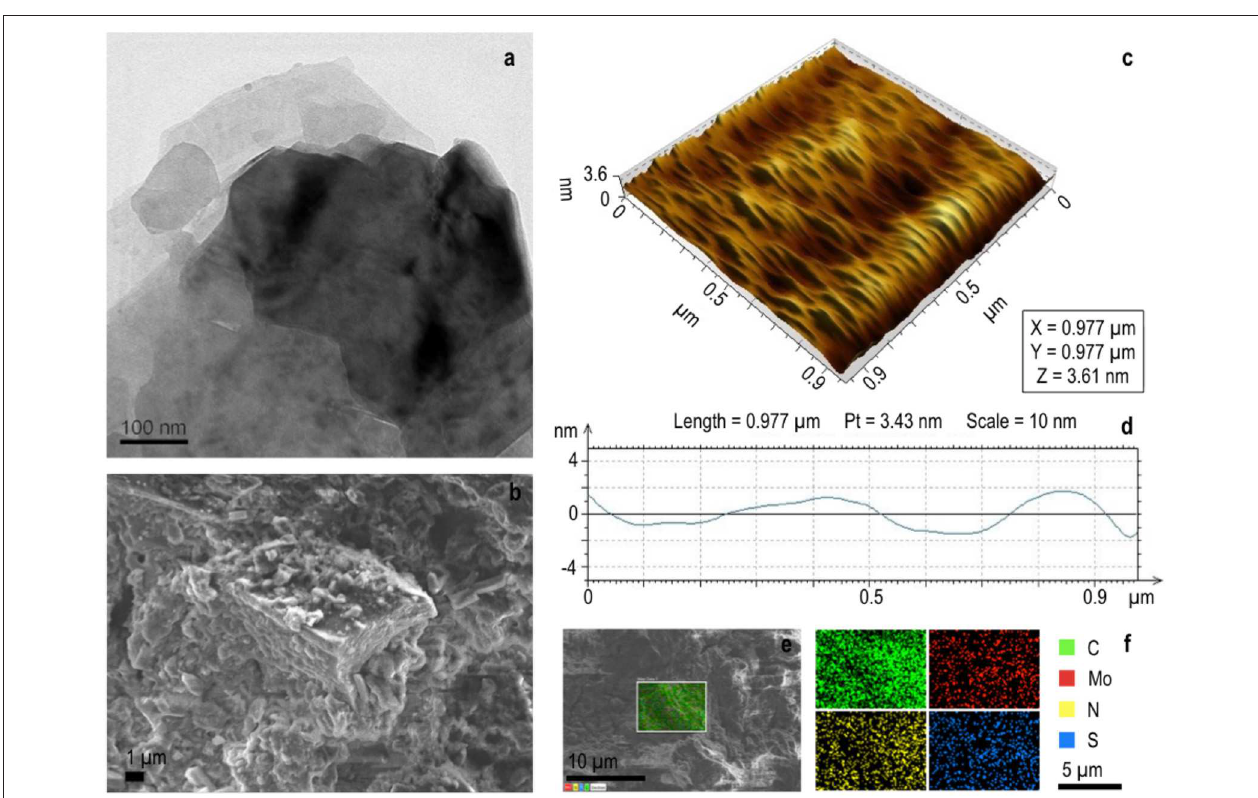
FIGURE 7 | Structural analysis of NDRGO-Mo-Li-2S. (a) Representative TEM image. (b) Representative FESEM image showing lamellar structure. (c) AFM image. (d) Height profile of the material in AFM. (e) Representative site used for elemental analysis. (f) Elemental analysis for C, N, Mo and S.